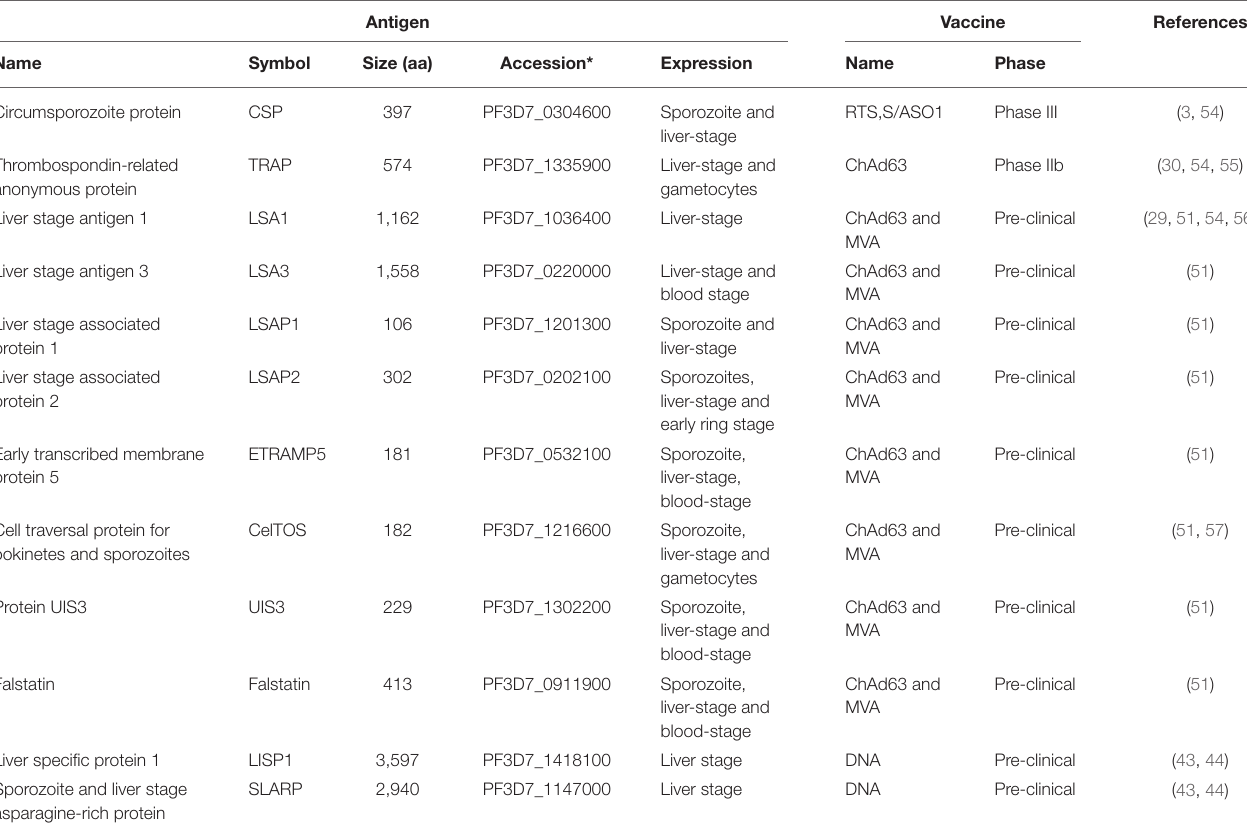
TABLE 2 | Pre-erythrocytic antigens used in vaccines.